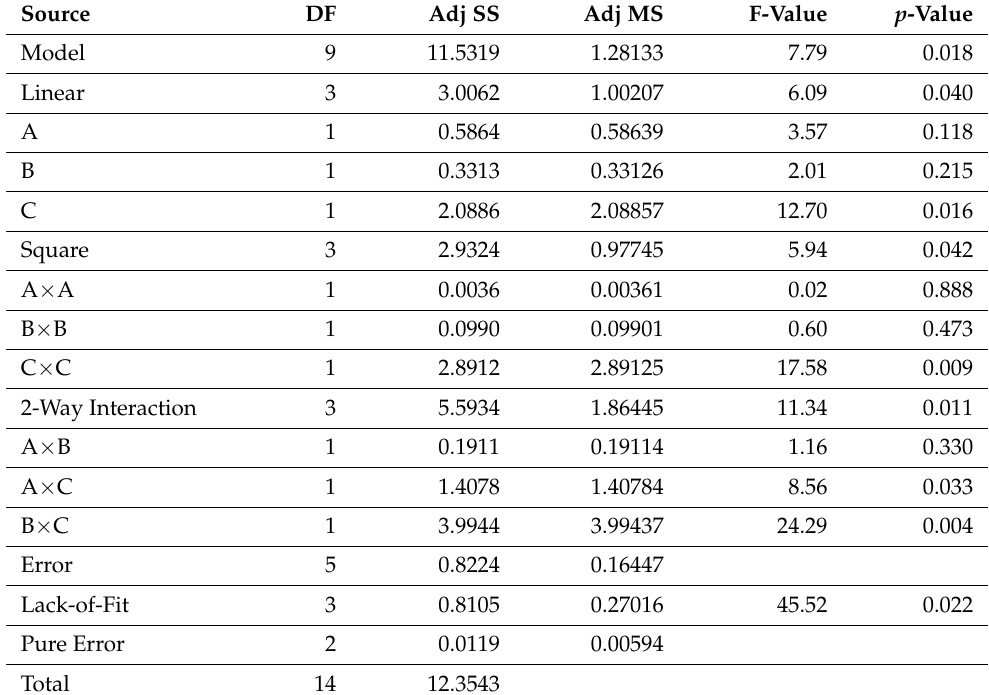
Table 6. ANOVA results for shear